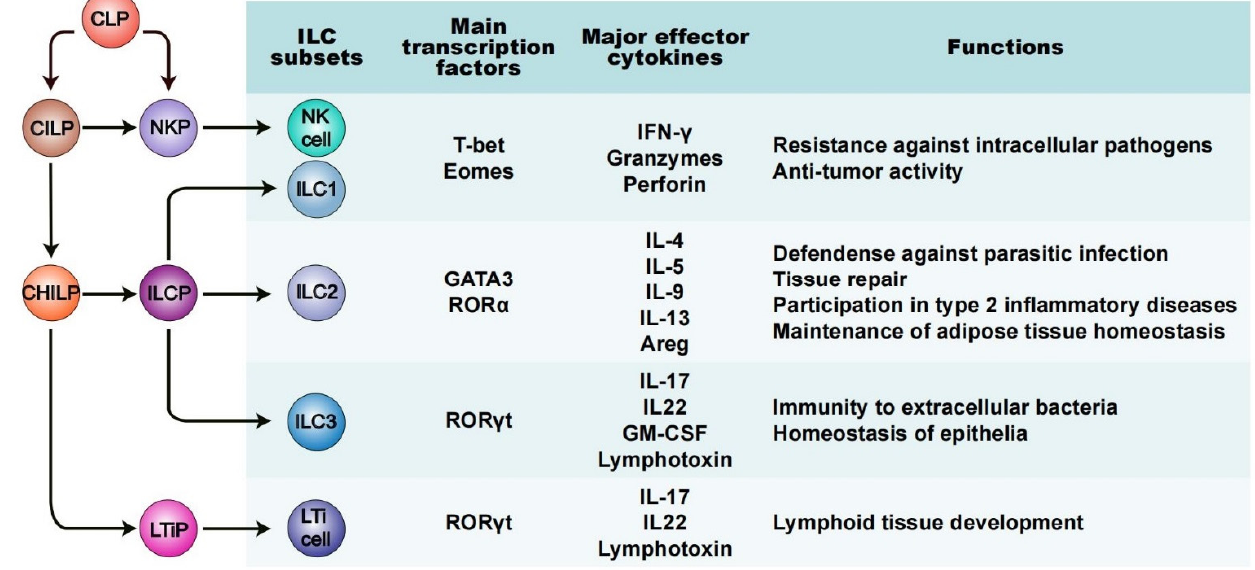
Figure 1. Development and the main features of ILC subsets. ILCs are derived from common lymphoid progenitors (CLPs) found within fetal liver and adult bone marrow. Dedicated TFs restrain B and T cell fates but guide the development of different ILC subsets. CLPs develop into common lymphoid progenitors (CILPs); then, through a series of transcriptional regulation processes, CILPs differentiate into natural killer cell precursor (NKPs) or common helper innate lymphoid progenitor (CHILPs), and the latter give rise to innate lymphoid cell precursor (ILCPs) and lymphoid tissue inducer progenitor (LTiPs). Each kind of precursor cell involves a branch in the ILC family. Based on the differential development trajectories and functions, the ILC family is categorized into five groups: NK cells, ILC1s, ILC2s, ILC3s and LTi cells. Each ILC subset secretes different effector cytokines that promote important physiological or pathological reactions.